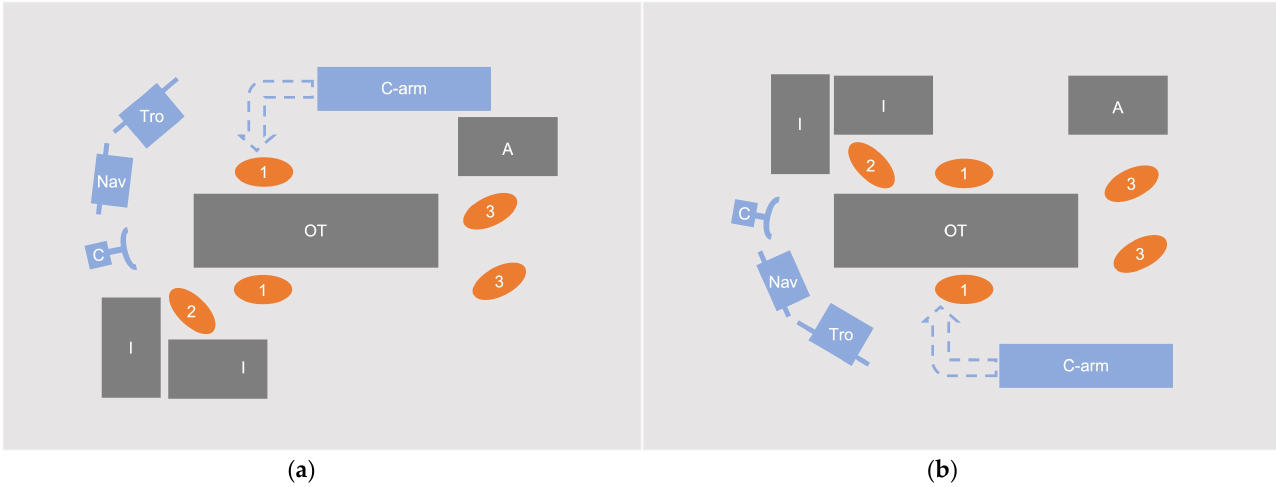
Figure 1. Different intraoperative settings for ( a ) upper thoracic procedures and ( b ) mid/lower thoracic and lumbosacral procedures. The system is placed at the end of the operating table for ergonomic viewing. 1: surgeons, 2: scrub nurse, 3: anesthesiologist/anesthesiologic nurse, A: anesthesiology unit, C: camera unit, C-arm: 3D C-arm, I: instrumentation trays, Nav: navigation monitor cart, OT: operating table, Tro: C-arm Trolley.